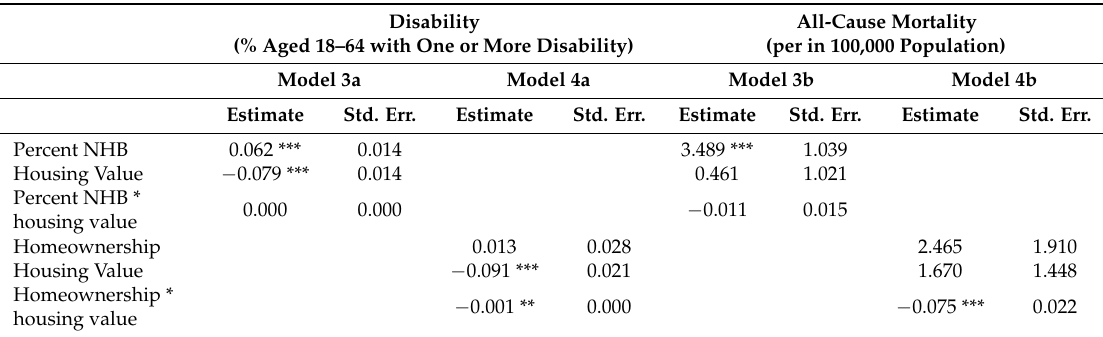
Table 3. Modification of the association between percent NHB and health outcomes (Models 3a and 3b) and homeownership and health outcomes (Models 4a and 4b) by neighborhood housing